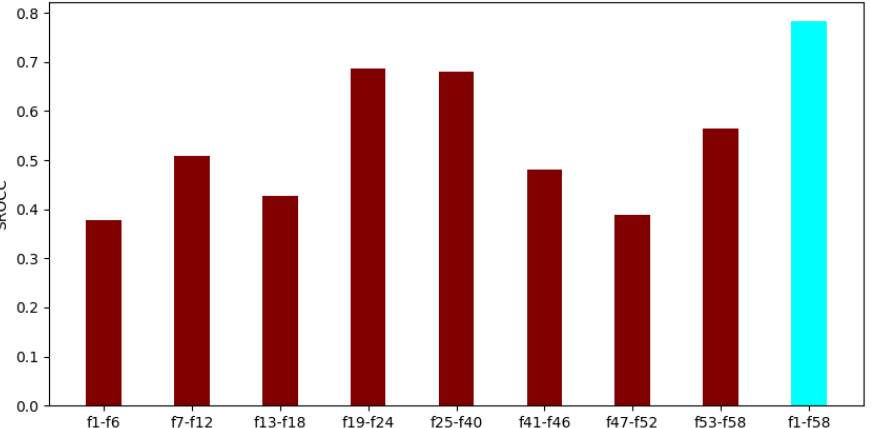
Figure 9. Performance comparison of the global and local features in FLG-VQA. The median SROCC values were measured on KoNViD-1k [16] over 1000 random training–testing splits. Table 1 gives information about the interpretation of the feature indices.